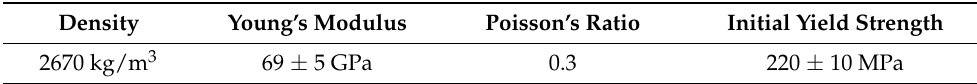
Table 3. Material properties of AlSi10Mg alloy.